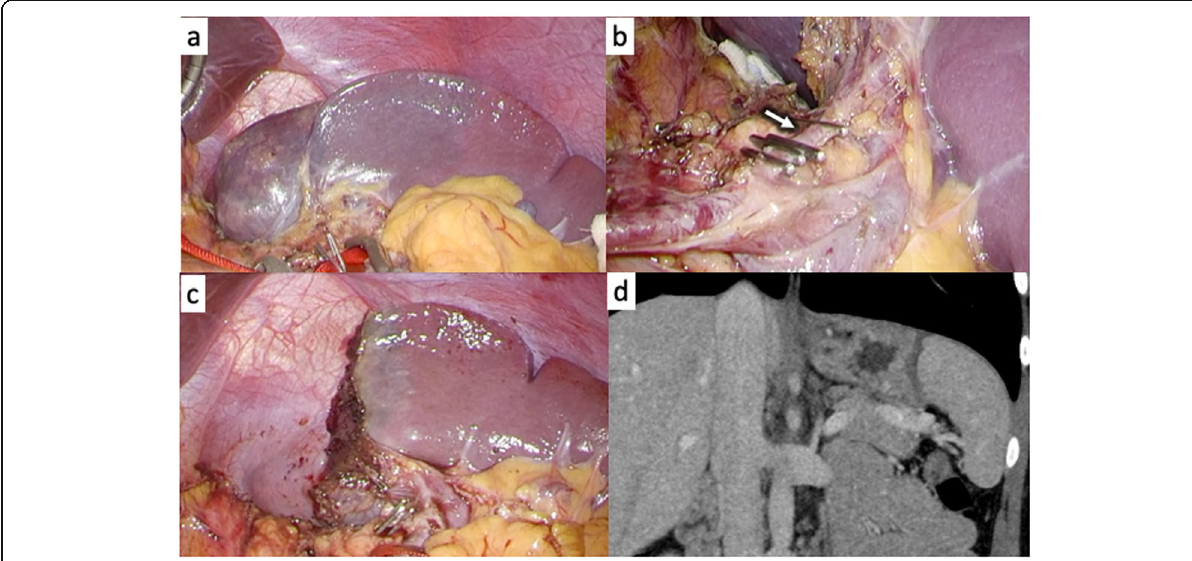
Fig. 3 The demarcation line appears after the upper pole branch of the splenic vessels is clamped ( a ). The upper pole branch of the splenic vessels is divided ( b ); the arrow shows the upper pole branch of the splenic vessels. The spleen is dissected approximately 1 cm from the ischemic side of the demarcation line with less bleeding ( c ). Computed tomography a year after surgery shows a spleen with preserved blood flow ( d